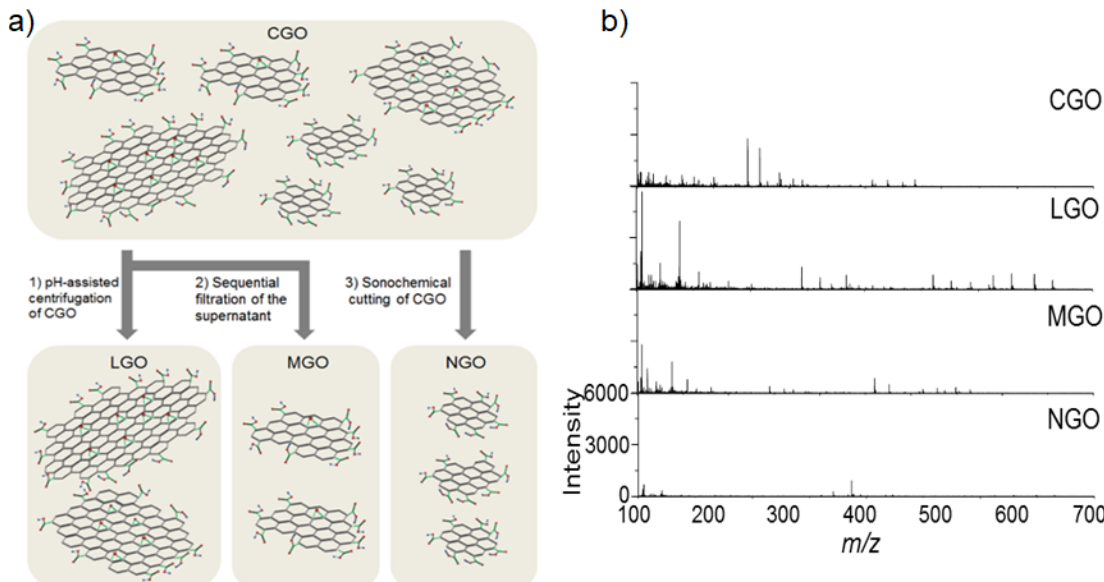
Figure 1. ( a ) A schematic diagram of size-fractionalization of GO flakes depending on their lateral of dimension. ( b ) LDI- TOF-MS spectra of small molecules obtained by using size-fractionalized GO flakes. Adapted with permission from ref. [64]. Copyright 2015 Wiley-VCH.